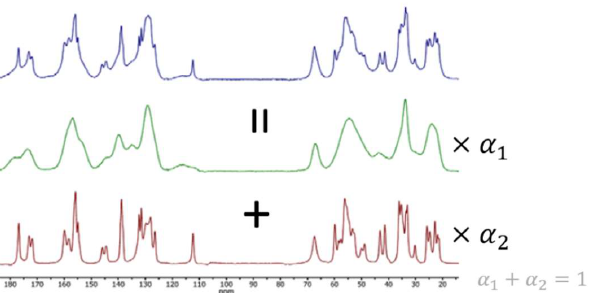
Figure 1. The mixture ssNMR spectrum (in blue) of a compound of interest contains contributions of crystalline (red) and amorphous (green) solid-state forms. The proportions of the two solid-state forms present in the physical mixture can be determined by deconvolution of the mixture spectrum into the two separate pure-component spectra. Only spectrum real parts are shown.